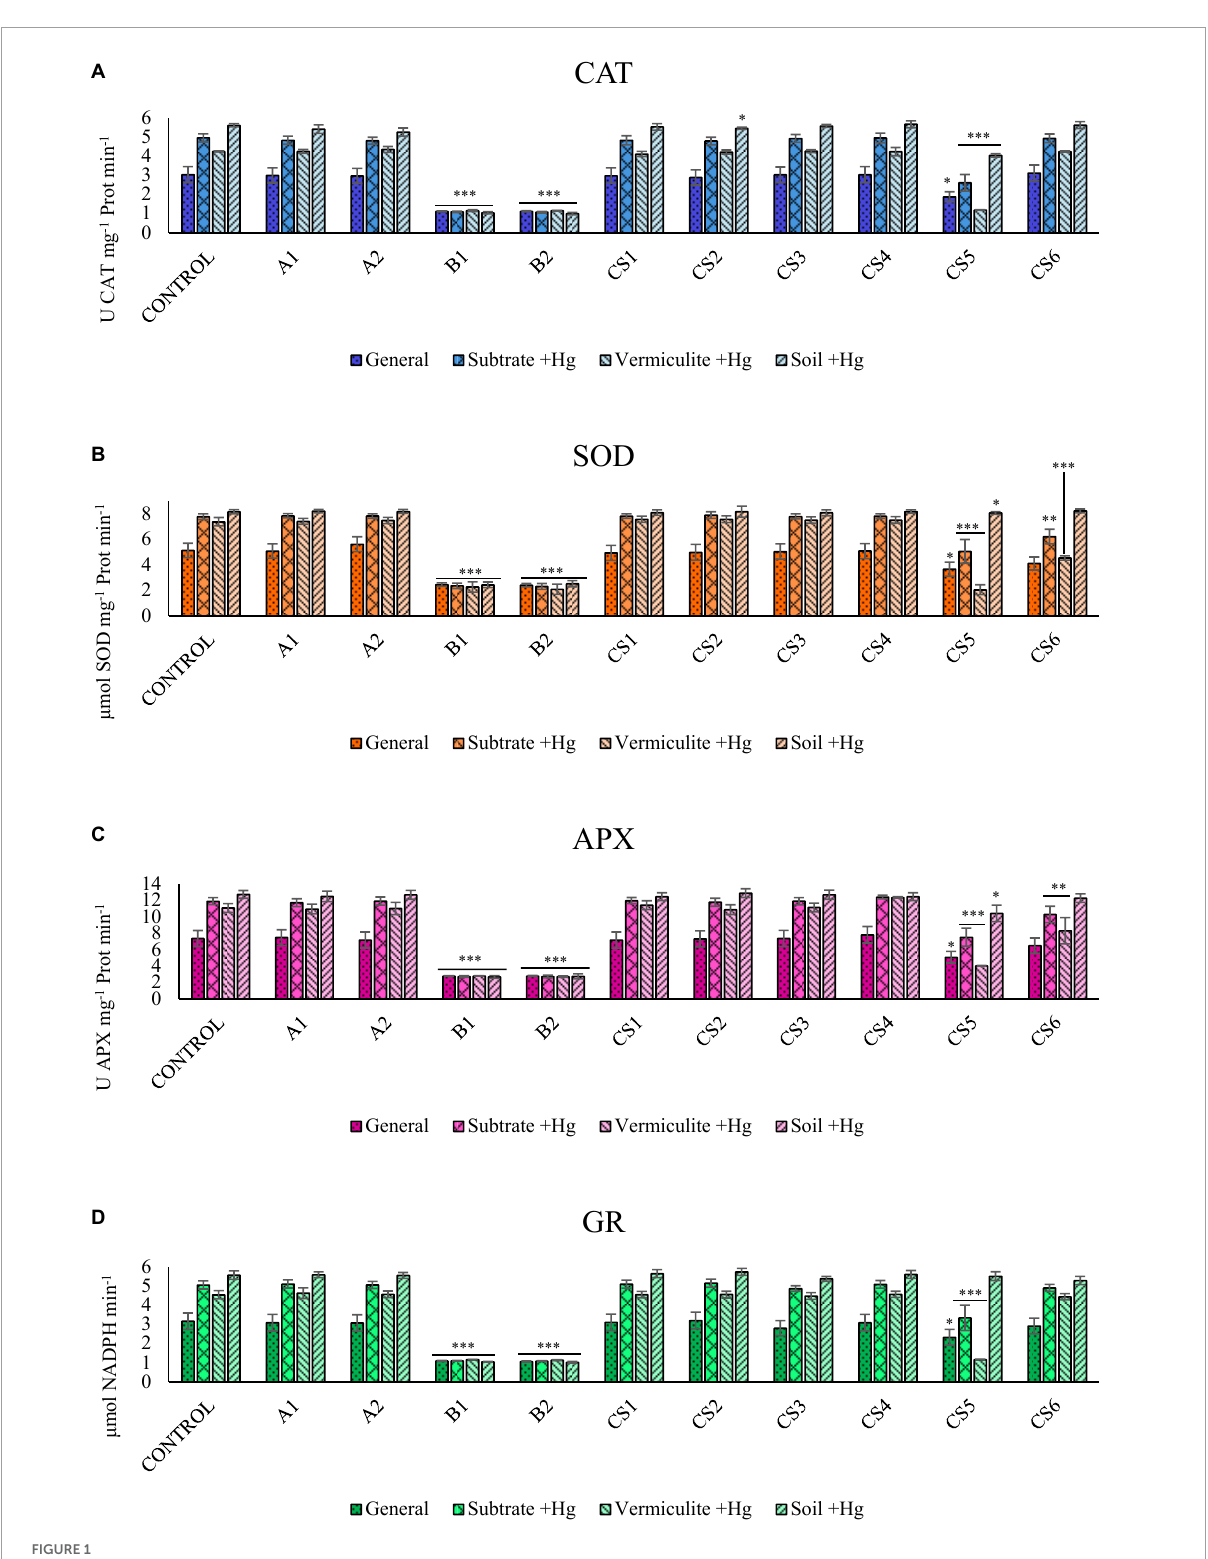
FIGURE1 Kruskal–Wallis ANOVA results for enzyme activity: CAT (A) , SOD (B) , APX (C) , and GR (D) . Data clusters for statistical treatment: “General”: dataset for plants grown in all growing matrixes; “Substrates +Hg”: dataset for plants in Hg supplemented vermiculite (“Vermiculite +Hg”) and soil with high Hg concentration (“Soil +Hg”); “Vermiculite +Hg”: dataset for plants in supplemented vermiculite; “Soil +Hg”: dataset of plants in soil with Hg high concentration. The bars indicate the standard error. Asterisks indicate the level of significance compared to control; ∗ p -value ≤ 0.05, ∗∗ p -value ≤ 0.003, and ∗∗∗ p -value ≤